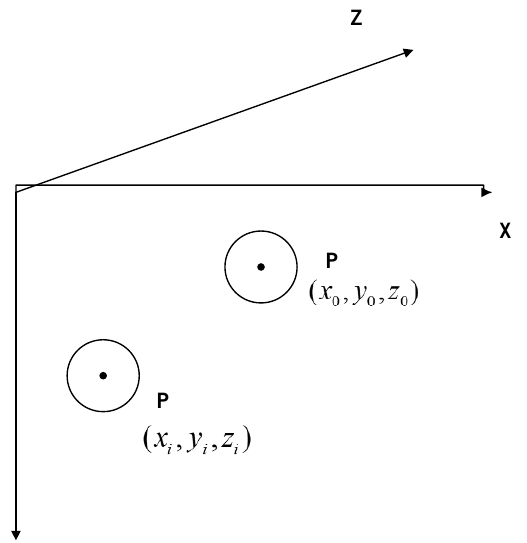
Figure 5. Schematic of measurement point displacement before and after structure deformation.